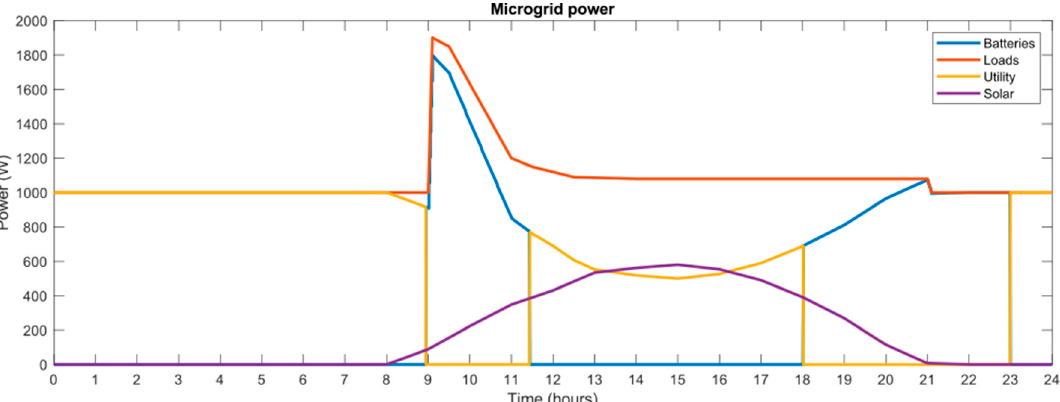
Figure 13. Microgrid powers.